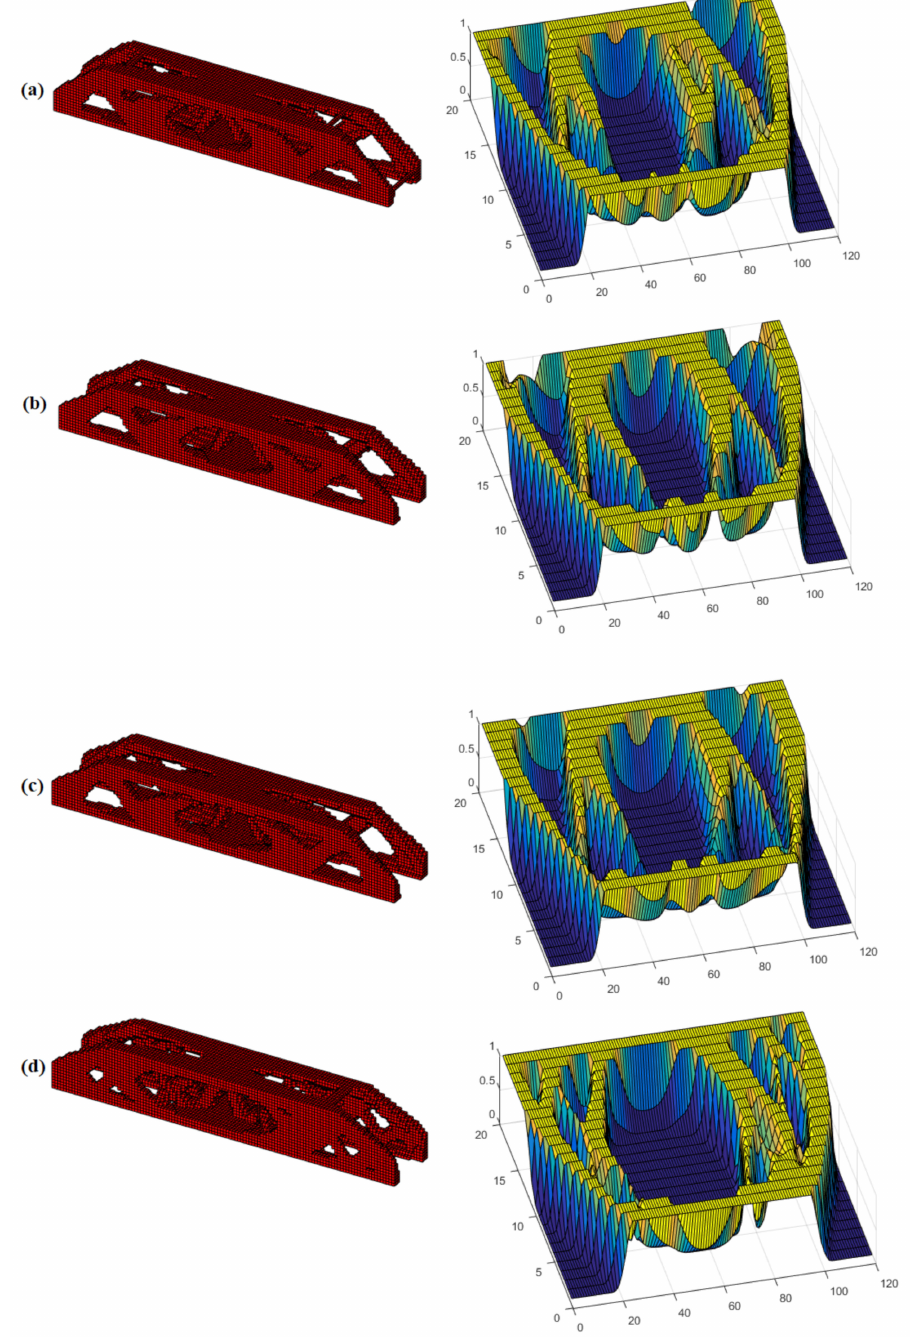
Figure 10. Optimal topology (RBTO), side view and surface: ( a ) ESO, ( b ) SERA, ( c ) SESO and ( d )